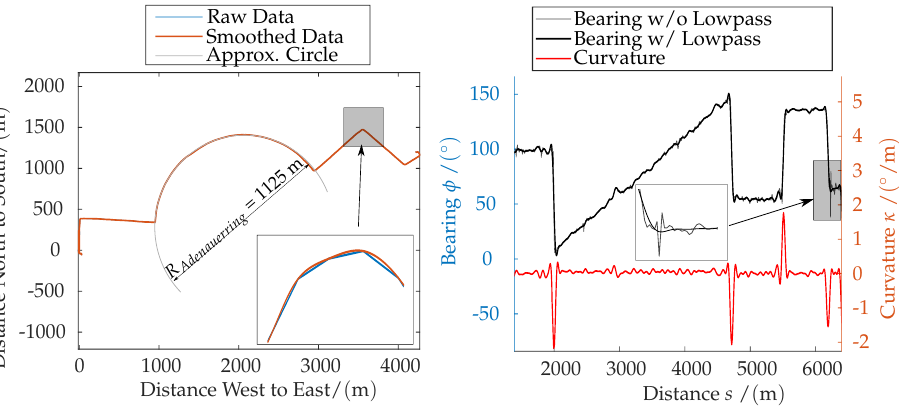
Figure 10. Two-step filter methodology for curvature calculation: Visualisation of the smoothPathSpline (left) and calculated bearing and curvature (right) using the lowpass filter In the left plot of Figure 10, both the Raw Data and the Smoothed Data of the GNSS 257 data can be seen. A radius of 1125 m can be calculated through cycle approximation. 258 In the right plot, the calculated bearing signal is plotted, both w/o (grey line) and w/ 259 lowpass filter (black line). Also, final curvatures are presented (red line). A ∆ bearing 260